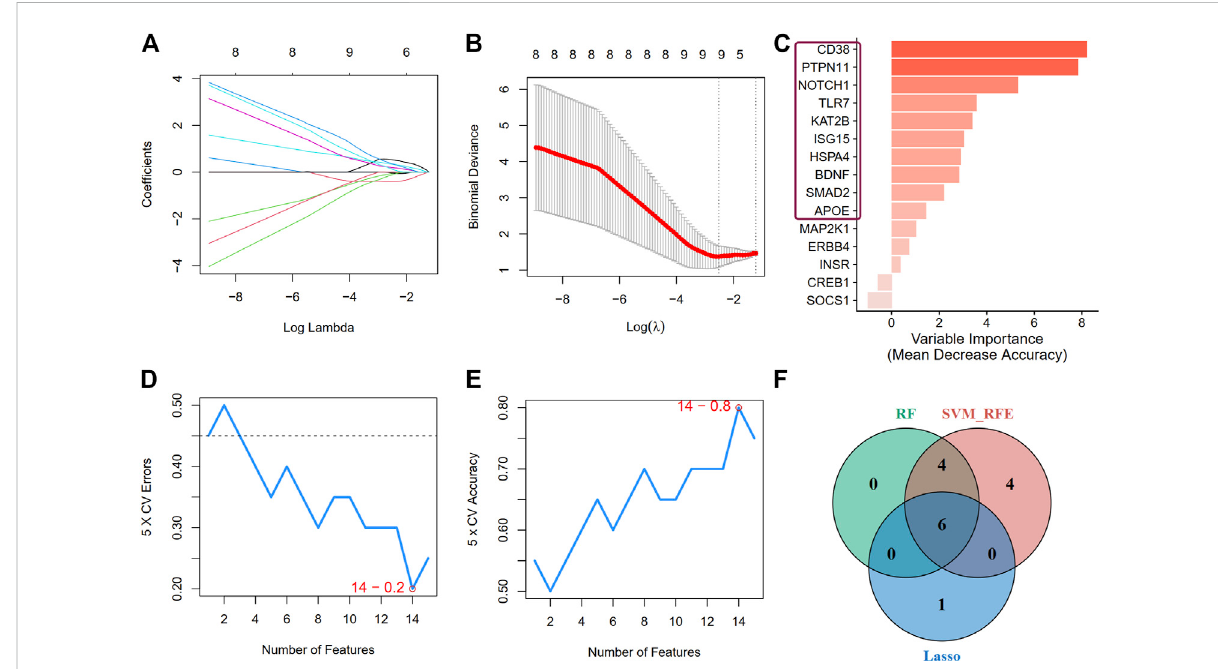
FIGURE 7 Screen for crucial DEARGs based on machine learning algorithms. (A,B) Feature selection by LASSO regression model (A) The coef fi cients change of different genes with different lambda (B) By verifying the optimal parameter (lambda) in the LASSO model, the partial likelihood deviance (binomialdeviance)curvewasplottedvslog(lambda). (C) Thegenesrankedbythefeatureimportancebasedonrandomforestalgorithm.Thedarker the color, the more important the gene is. (D) and (E) The error and accuracy of model changed with different number of features in support vector machine-recursive feature elimination method, respectively. (F) A Venn diagram demonstrating six diagnostic markers shared by the three algorithms.